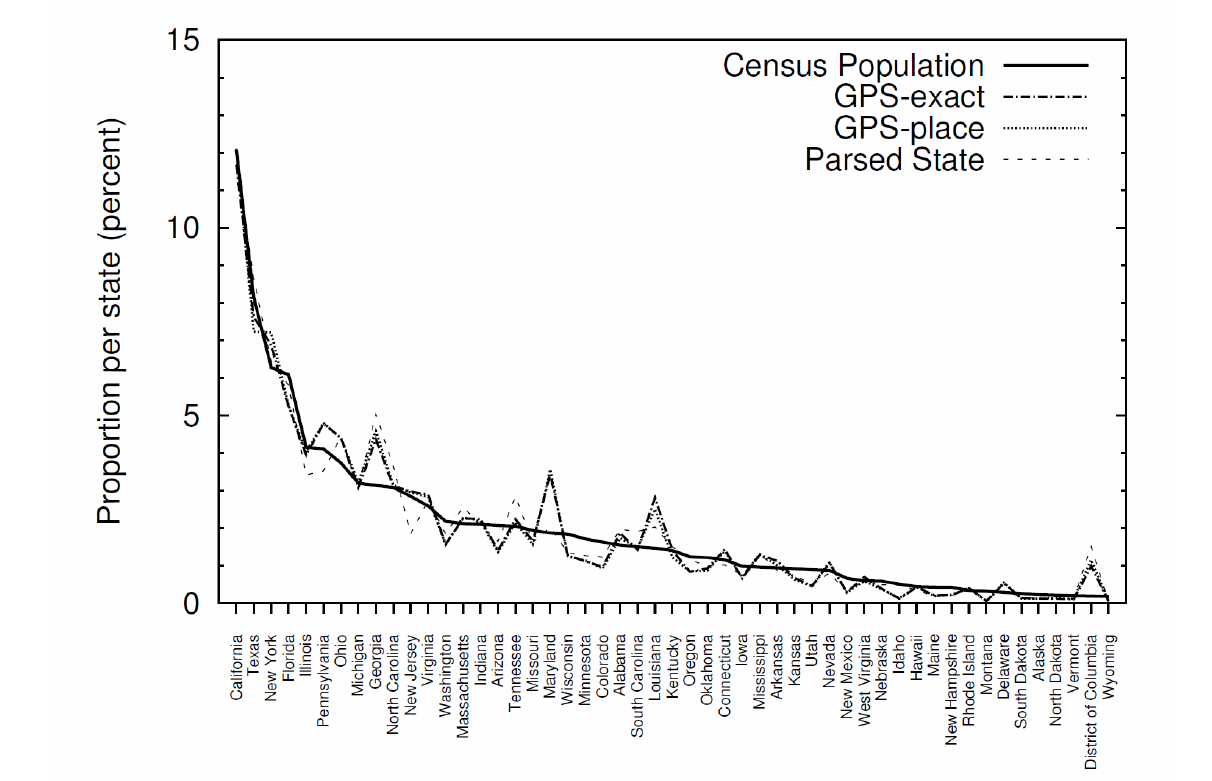
Figure 3. The proportion of Twitter users identified in each state and the proportion of the 2010 US census population in each state, ordered by census